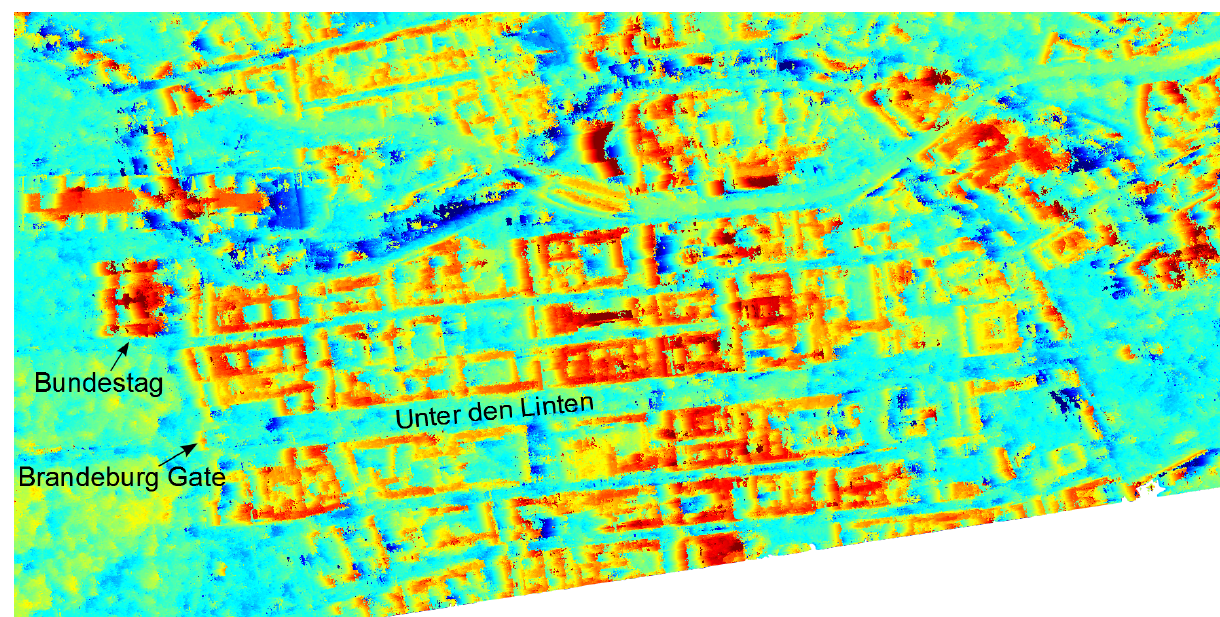
Figure 13: Portion of the experimental Raw DEM over the city